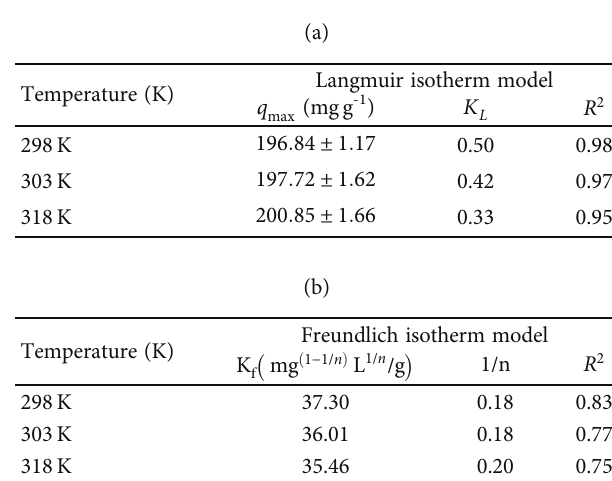
Table 5: Parameters of phosphorus adsorbed based of the Langmuir and Freundlich isotherm